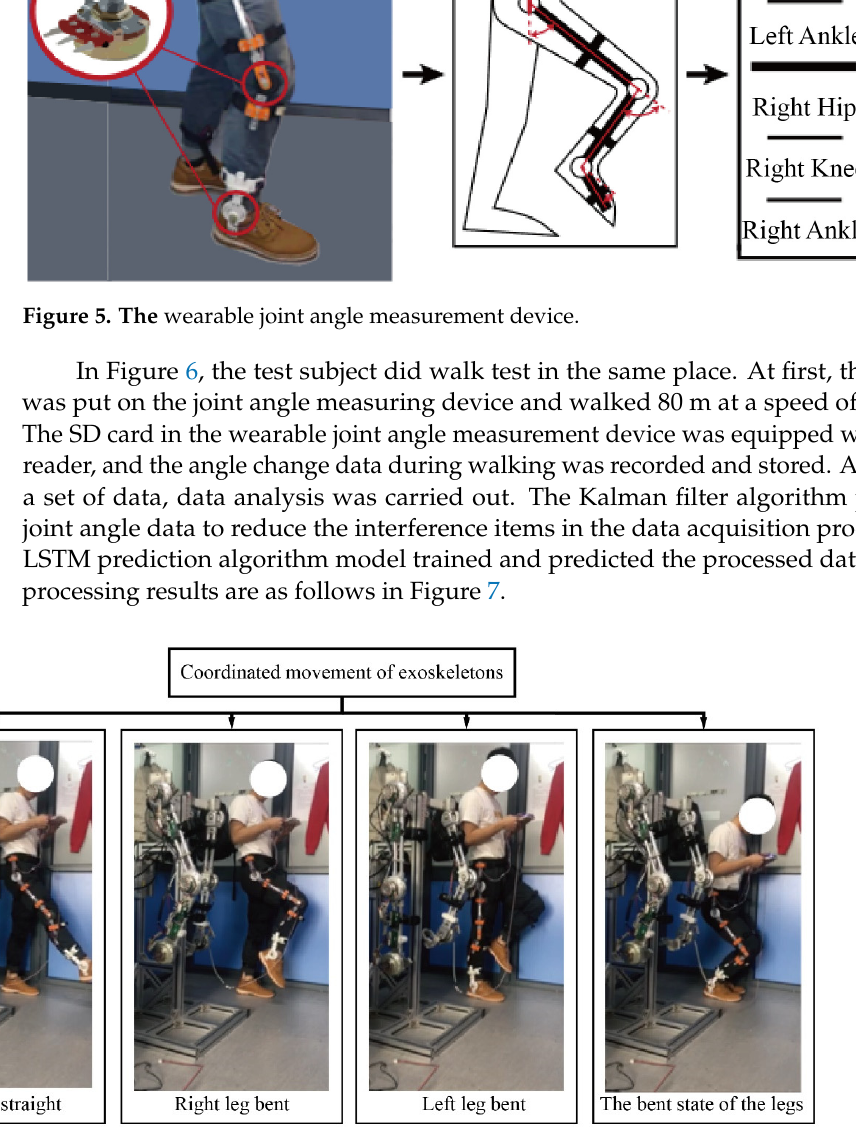
Figure 6. Cooperation movement of the lower limb exoskeleton and human.